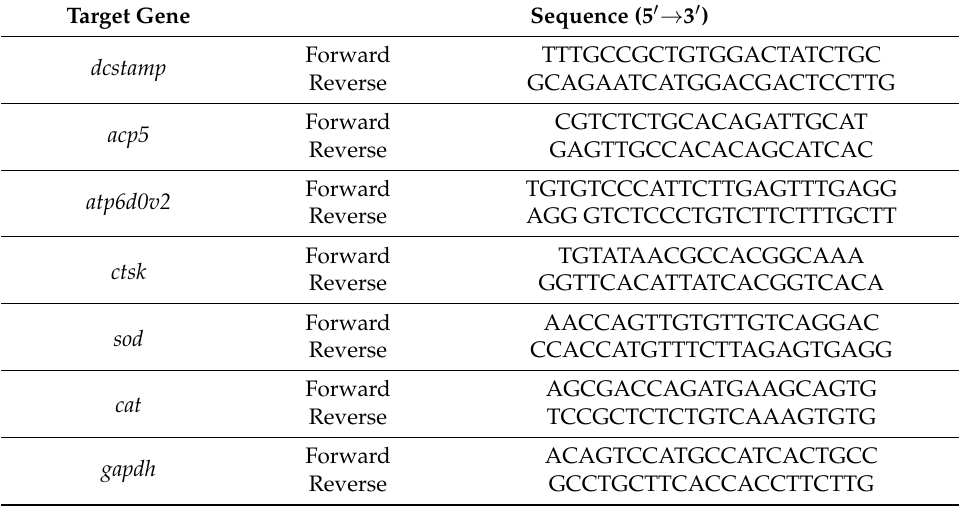
Table 1. Primer sequences for real-time quantitative PCR